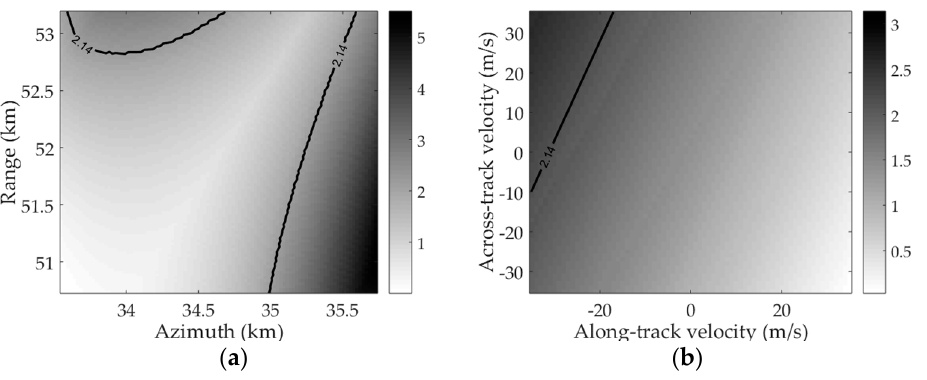
Figure A1. Residual RCM after KT with acceleration: ( a ) moving target with different locations; and ( b ) moving target with different velocities.